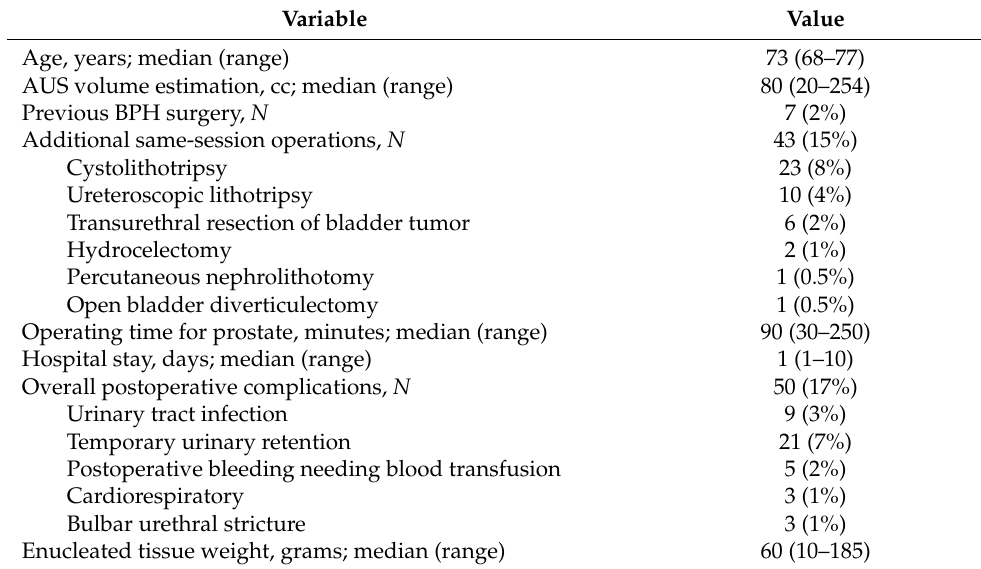
Table 1. Study population characteristics ( n =